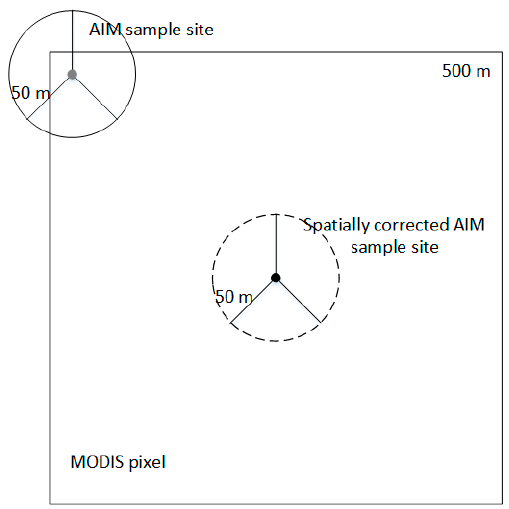
Figure 1. An Assessment, Inventory, and Monitoring (AIM) sample site (solid line) is off center from the center of a Moderate-Resolution Imaging Spectroradiometer (MODIS) pixel. After relocating the sample site, the spatially corrected AIM sample site (dotted line) is at the center of a MODIS pixel.